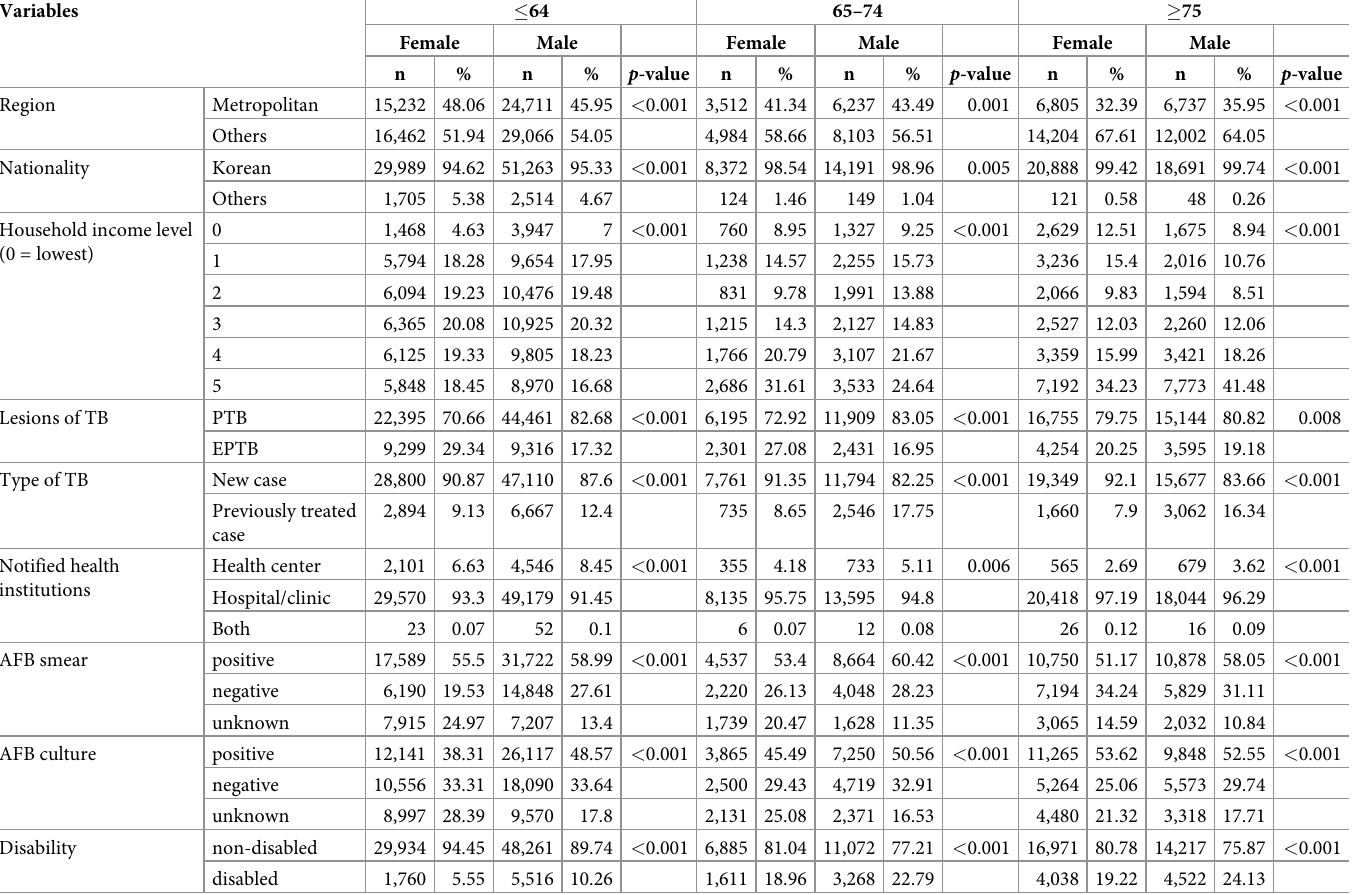
28.6% in 2014 to 41.1% in 2018 ( p < 0.001). Regarding the distribution by age group, a lower percentage of both men and women in all age groups lived in metropolitan cities (Table 1). Regarding household income level, the percentage of those belonging to the lowest-income (0) and high-income (5) groups tended to increase in the older population compared with those aged � 64 years ( p < 0.001). The results showed that the distributions of all covariates in all age groups were significantly different between men and women (Table 2). However, the Table 2. Baseline characteristics of female and male patients with tuberculosis by age group.